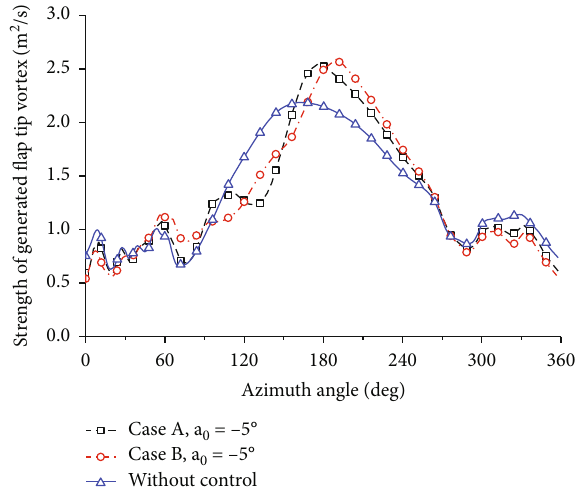
Figure 14: Graph of the variation in the fl ap tip vorticity of the sample ECR with the